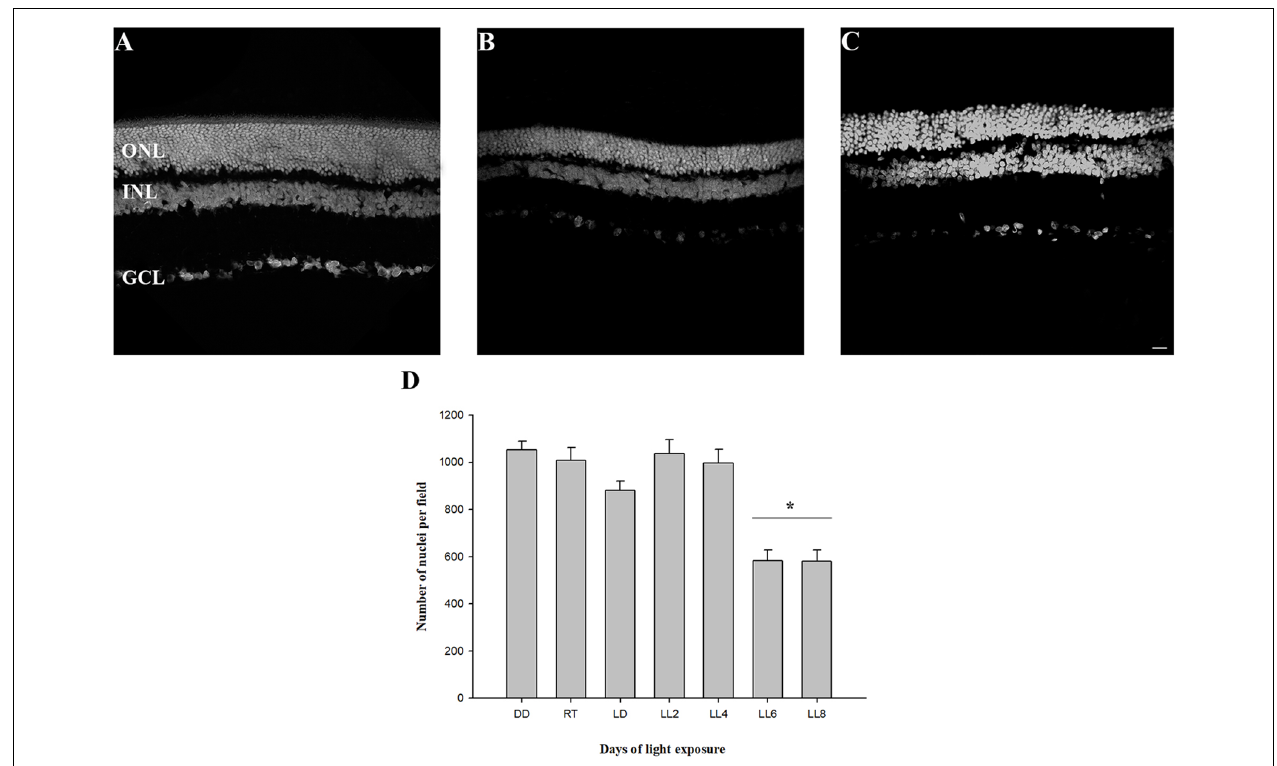
FIGURE 1 | Outer nuclear layer analysis. (A) Rat retinas maintained in dark for 7 days (DD). (B–C) Retinas from rats exposed 6 (LL6) or 8 (LL8) days to constant light (200 lx). (D) Quantification of ONL nuclei; rat retina images corresponding to controls [(LD cycle, RT cycle and non-exposure to light (DD)] or exposure to 200 lx LED light (LL) for 2, 4, 6, and 8 days were analyzed to quantify photoreceptor survival. Data are mean ± standard error (SE), n = 2 animals/group from five independent experiments, ∗ p < 0.05 vs. DD and RT by one-way analysis of variance (ANOVA) and Duncan’s post hoc test. ONL, outer nuclear layer; INL, inner nuclear layer; GCL, ganglion cell layer. Scale bar indicates 30 µ